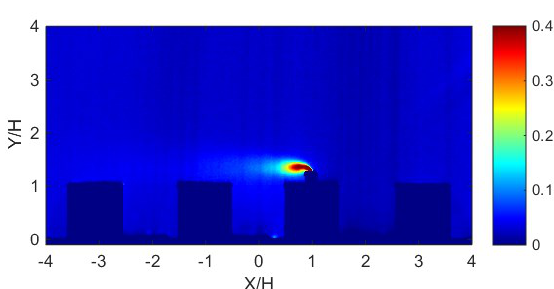
Fig. 9. Mean non- dimensional concentration C/C 0 field (C 0 is the mean concentration measured at the top of the chimneystack) for flat roof with a chimneystack (on the middle of the roof) with h/H = 0.25; the flow moves from the right to the